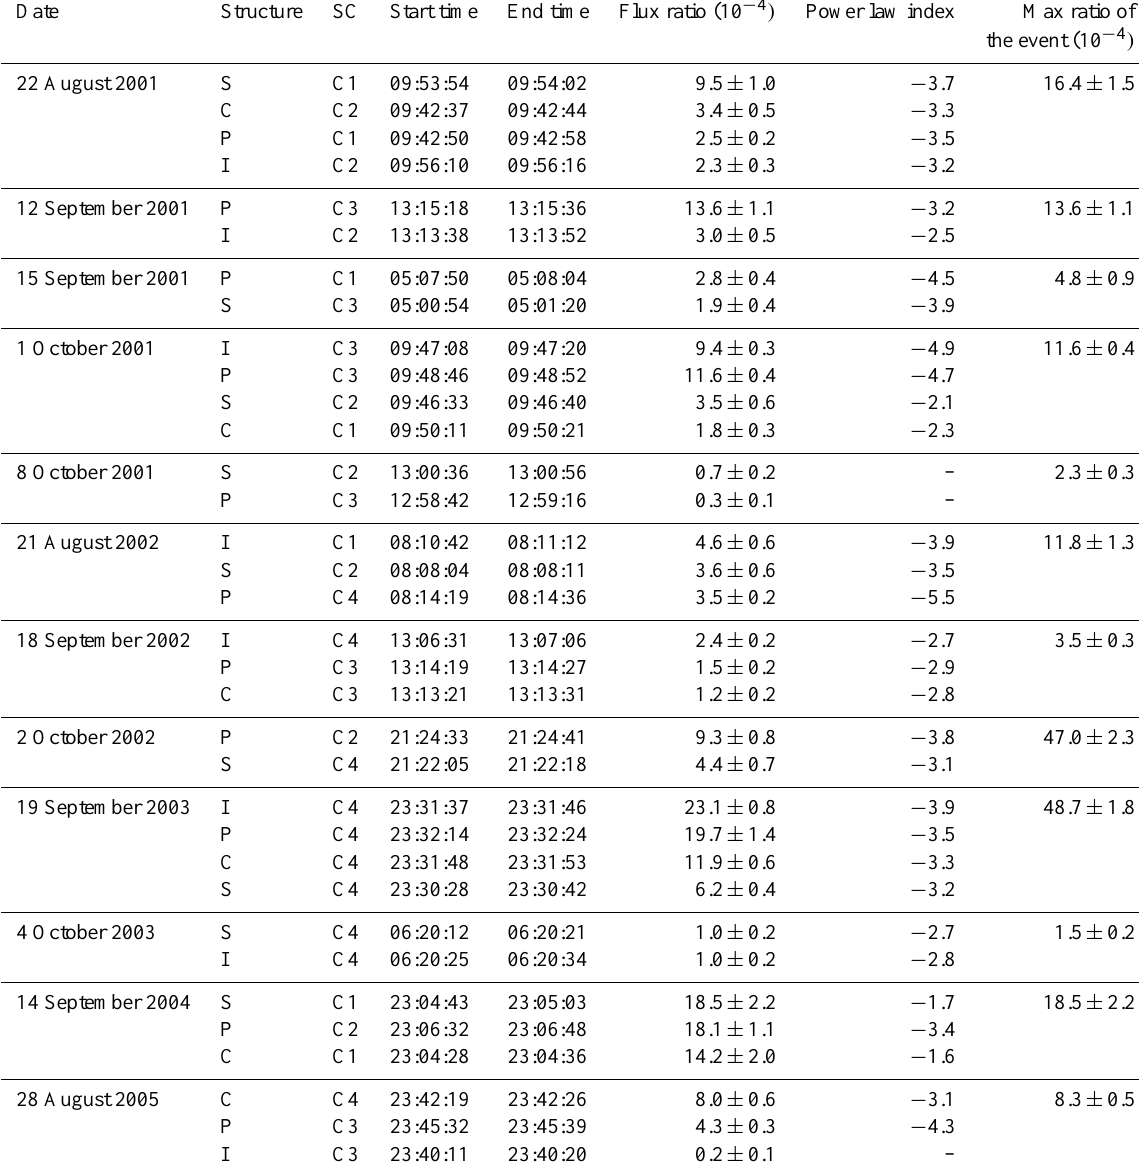
Table 1. A summary of flux ratio and power law indices within the different structures for all the selected reconnection events. “–” in the column of power law index corresponds to the integrated energetic electron flux less than 1000/(sstrcm 2 ) . For each event the structures are sorted in order of flux ratio from high to